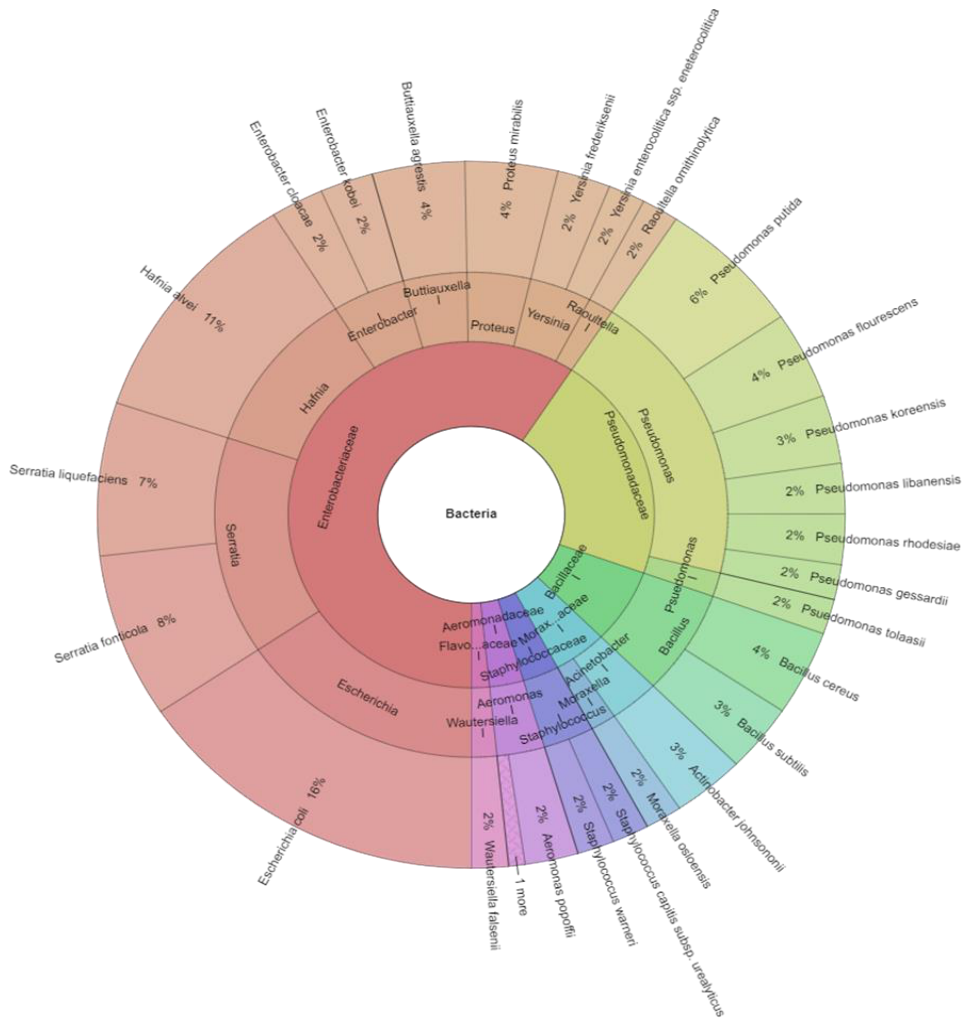
Figure 1. Krona chart: Isolated species of bacteria from marinated raw products.